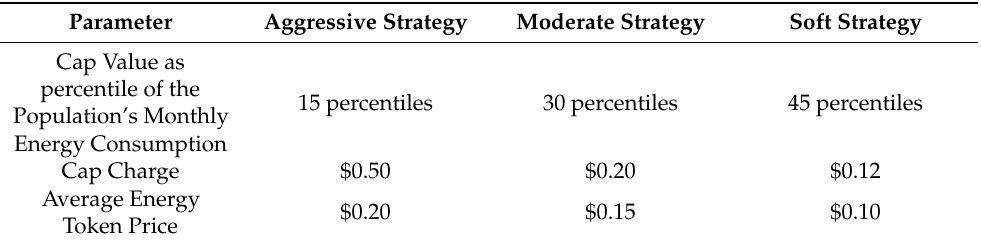
Table 2. Defined values for simulation